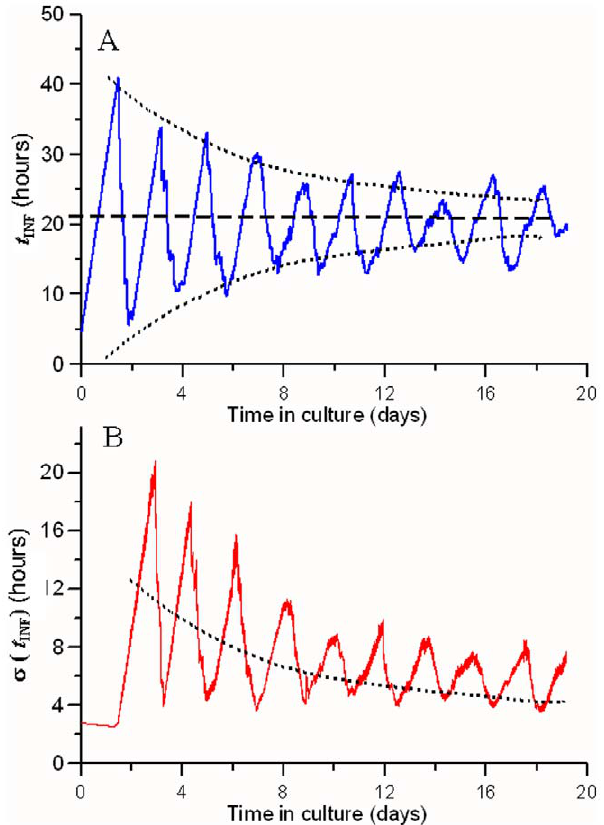
Figure 4. Simulated evolution of of post-invasion times. (A) mean value ( m ~ (cid:2) tt INF ) and (B) standard deviation ( s t distribution of post-invasion times among a simulated population of IRBCs. Dashed line indicates the asymptotic trend towards: m ~ 18 : 2 hours . Dotted line depicts the correspondence between the envelope of m and the mean value of s˜ m and s are approximately 180 u out of phase because s reaches its maximum value when the generalized outburst of the parasite takes place; at that moment, m has a medium value because most of the IRBCs are at the end of their infection cycle while the next generation of parasites is already rising.